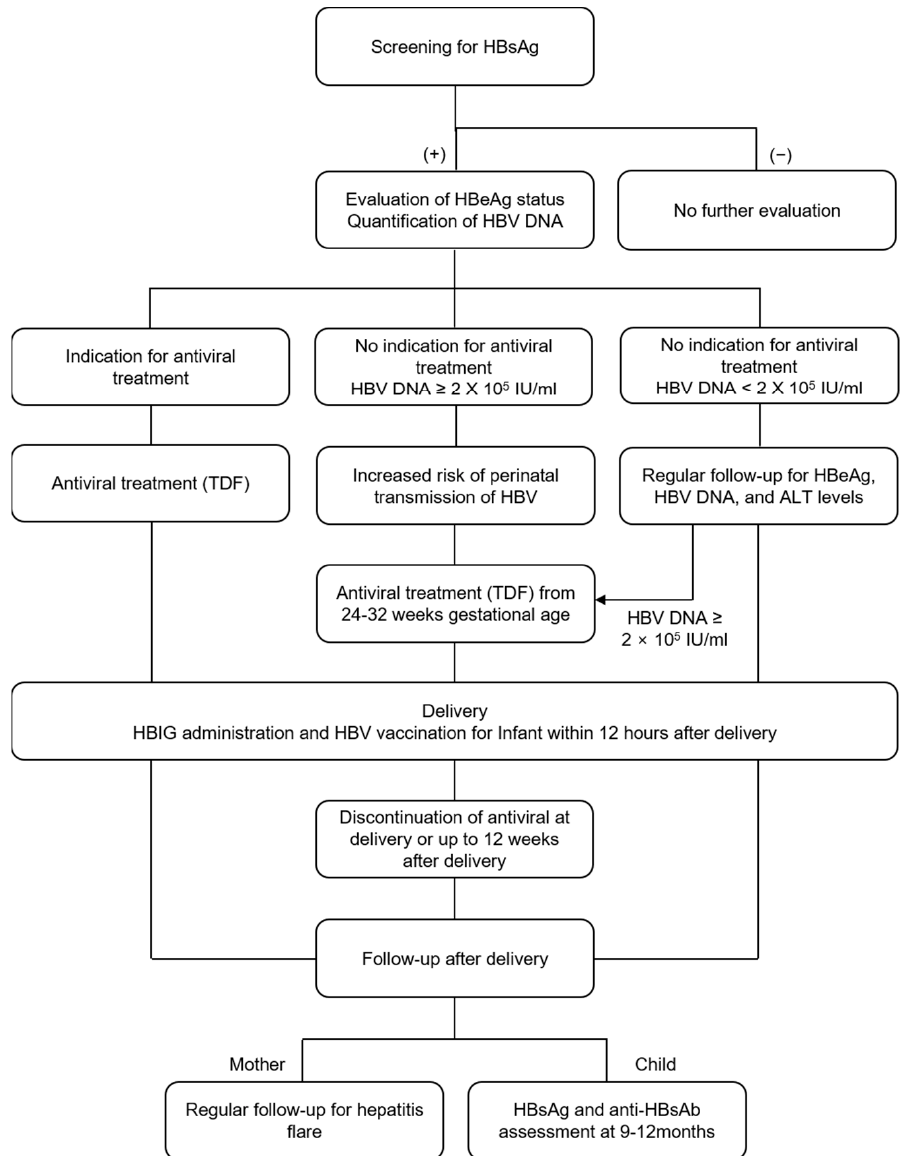
Figure 1. HBV screening and prevention of HBV MTCT in pregnant women. MTCT, mother-to- child transmission; HBsAg, hepatitis B surface antigen; HBeAg, hepatitis B envelope antigen; HBV DNA, hepatitis B virus DNA; IU, international units; TDF, tenofovir disoproxil fumarate; ALT, alanine aminotransferase; HBIG, hepatitis B immune